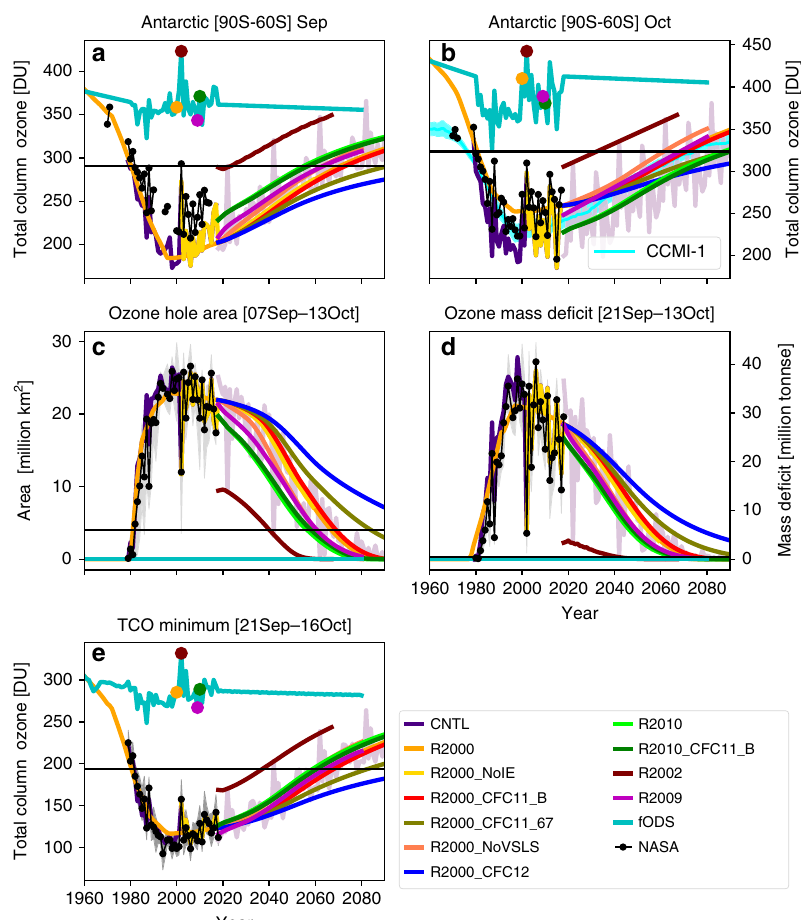
Fig. 3 Antarctic ozone and metrics quantifying ozone loss as a function of meteorology and additional CFC-11 emissions. Mean column ozone (DU) averaged from 90 o S to 60 o S for a September and b October from TOMCAT simulations CNTL (control), fODS ( fi xed ozone-depleting substances), R2000, R2002, R2009, R2010 (repeating meteorology from 2000, 2002/2003, 2009/2010 and 2010/2011, respectively), R2000_NoIE (no increased CFC-11 emissions), R2000_NoVSLS (no chlorinated very short-lived substances), R2000_CFC11_67 (with constant CFC-11 emissions of 67 Gg yr − 1 ), R2000_CFC11_B and R2010_CFC11_B (with additional CFC-11 emissions from box model for 2000 and 2010/2011 meteorology, respectively) (see legend) from 1960 to 2090. Panel b also shows mean (±1 σ cyan shading) chemistry-climate modelling initiative (CCMI) results 13 . Estimates of the size of the Antarctic ozone hole using c area contained within the 220 DU contour (×10 6 km 2 ) (averaged September 7 – October 13), d ozone mass de fi cit (×10 6 tonnes) (averaged September 21 – October 13) and e minimum column ozone (between September 21 and October 16). All panels also show observations (black line) from NASA Solar Backscatter Ultraviolet (SBUV) instrument ( a , b ) or https://ozonewatch.gsfc.nasa.gov/statistics/annual_data.htm ( c – e ). The coloured dots on the fODS line (panels a , b ) show the years used for simulations R2000, R2002, R2009 and R2010. The pink line in the background in all panels from 2018 to 2090 shows the results of the continuation of run CNTL with 20-year repeating